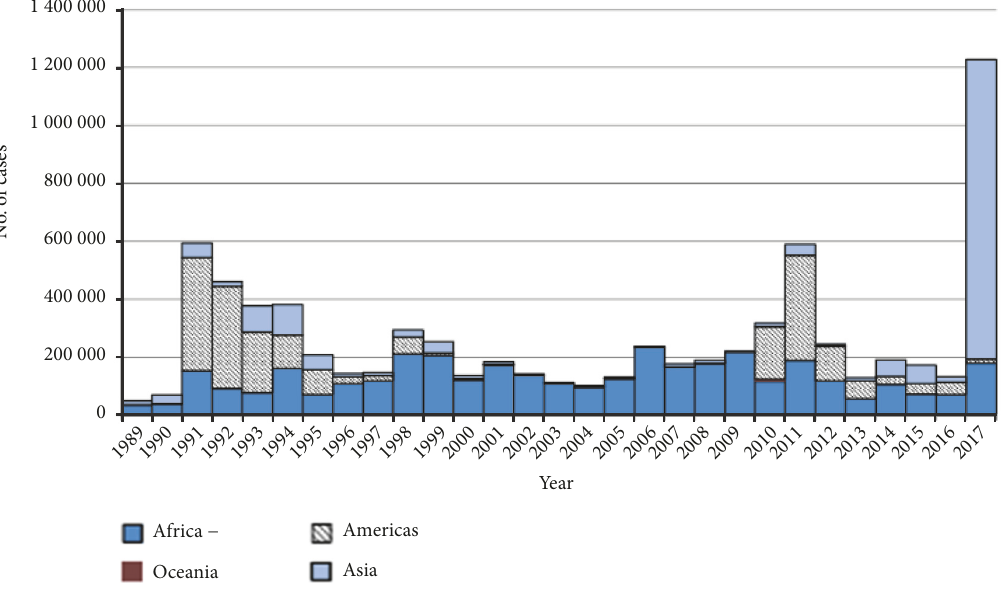
Figure 1: Cholera cases reported by WHO by a year and by continent from 1989 to 2017